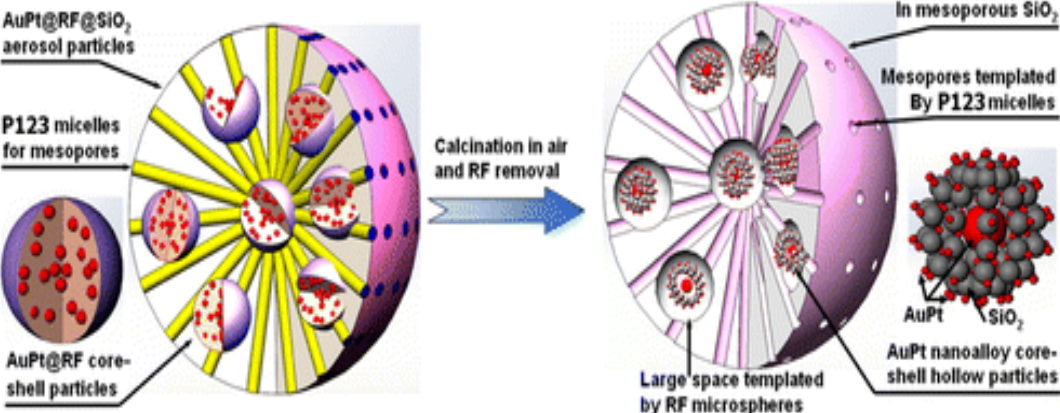
Figure 4. AuPt nanoalloy yolk@shell hollow particles in ordered mesoporous silica microspheres. Reproduced with permission from the authors of [100].